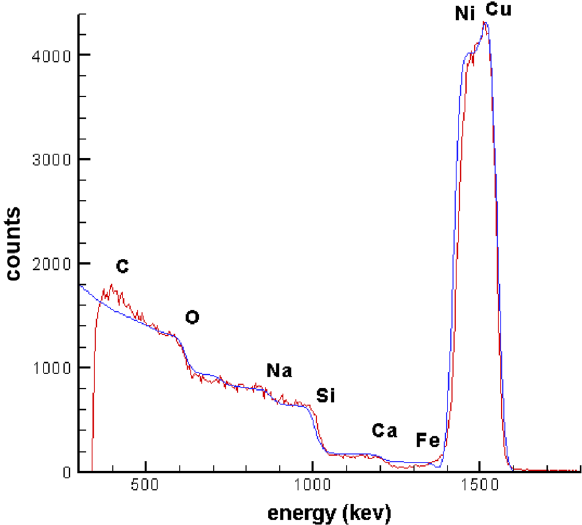
Figure 1. Experimental (red line) and simulated (blue line) RBS spectra of Cu/Ni sample.